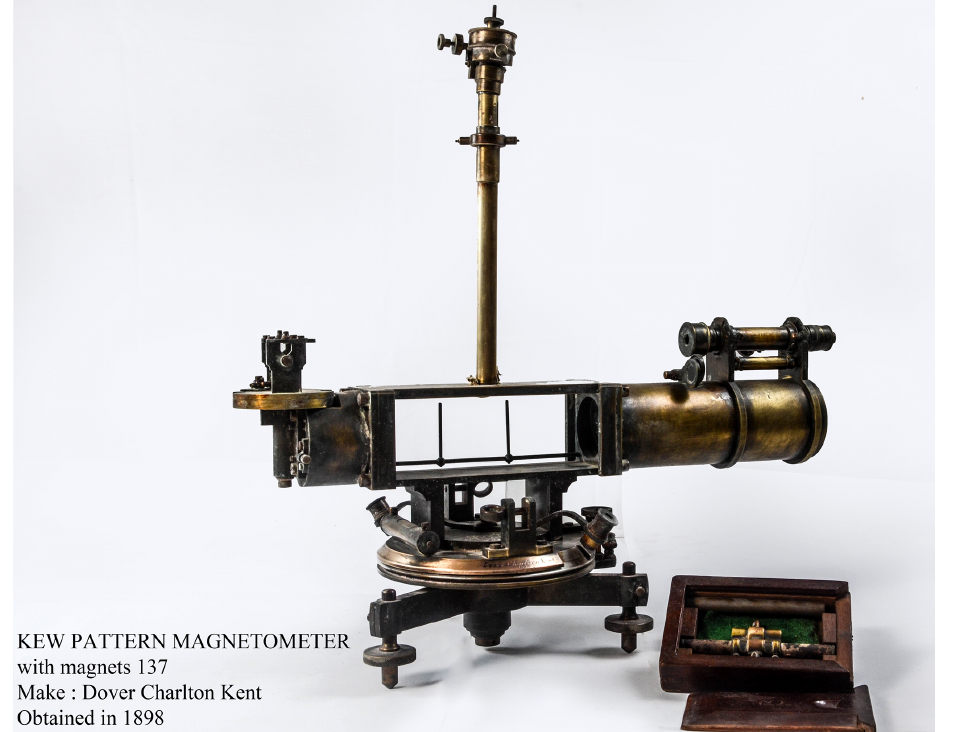
Figure 23. This magnetometer was used for deflection experiments (courtesy of Colaba–Alibag Observatory).